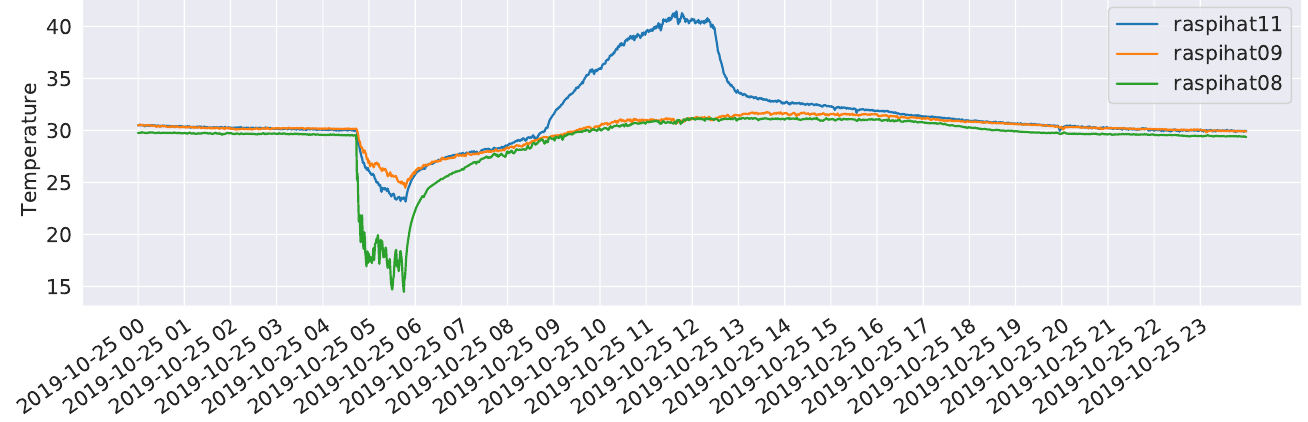
Figure 4. Temperatures recorded by sensors 8, 9, and 11 on the day 25 October